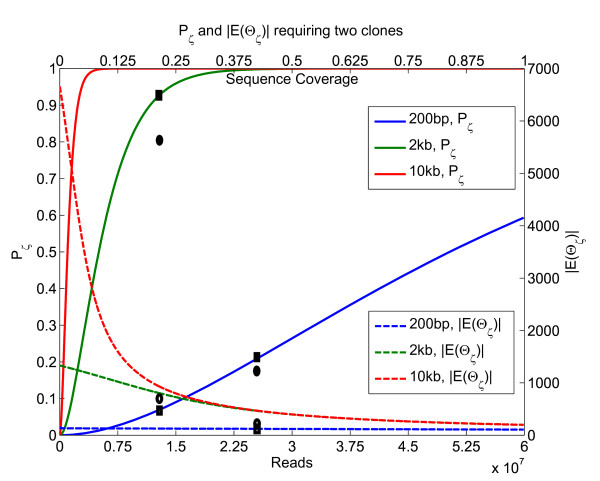
Detection-resolution trade-off. Figure 2: The detection probability, Pζ (left-axis), increases with increased sequencing (N), as well as insert-length (L). The expected resolution-ambiguity, |E(Θζ)| (right-axis), increases with increasing insert-length L. The bottom x-axis shows total number of reads (N) while the top x-axis shows the corresponding sequence coverage (with 50 bp paired reads relative to the human genome). □' and '●' correspond to the expected and observed values, respectively, for specific values of N and L.